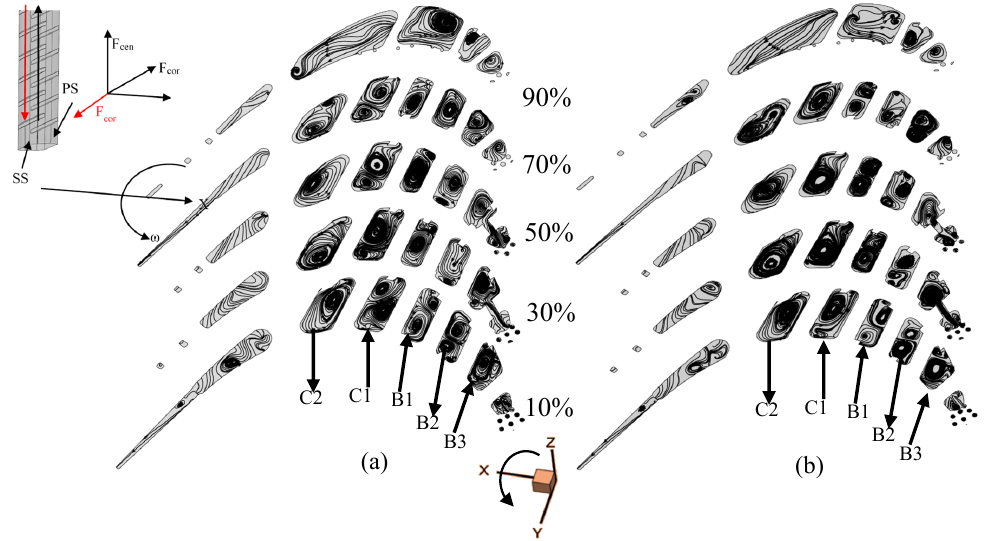
Figure 6. The streamlines for blade spans from 10% to 90% under ( a ) rotating condition; ( b ) station- ary